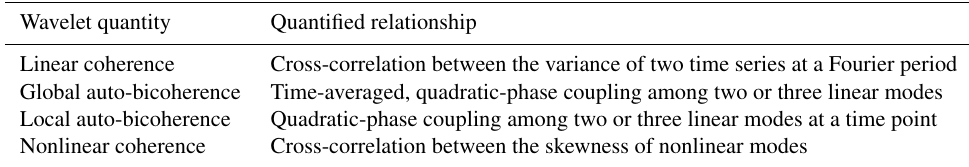
Table 1. Wavelet quantities and the relationships they measure. Wavelet quantity Quantified relationship Linear coherence Cross-correlation between the variance of two time series at a Fourier period Global auto-bicoherence Time-averaged, quadratic-phase coupling among two or three linear modes Local auto-bicoherence Quadratic-phase coupling among two or three linear modes at a time point Nonlinear coherence Cross-correlation between the skewness of nonlinear